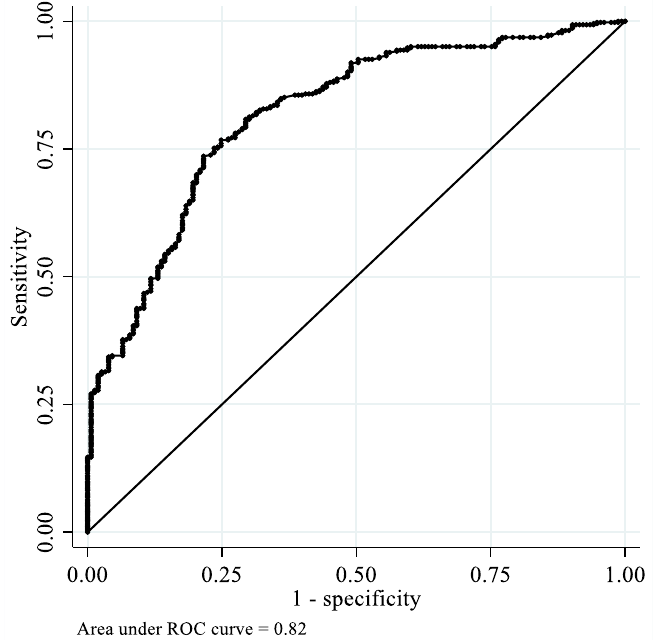
Figure 3. Receiver operating characteristic curves of OFMD-CPS-measured OF among the participants with <20 natural teeth.